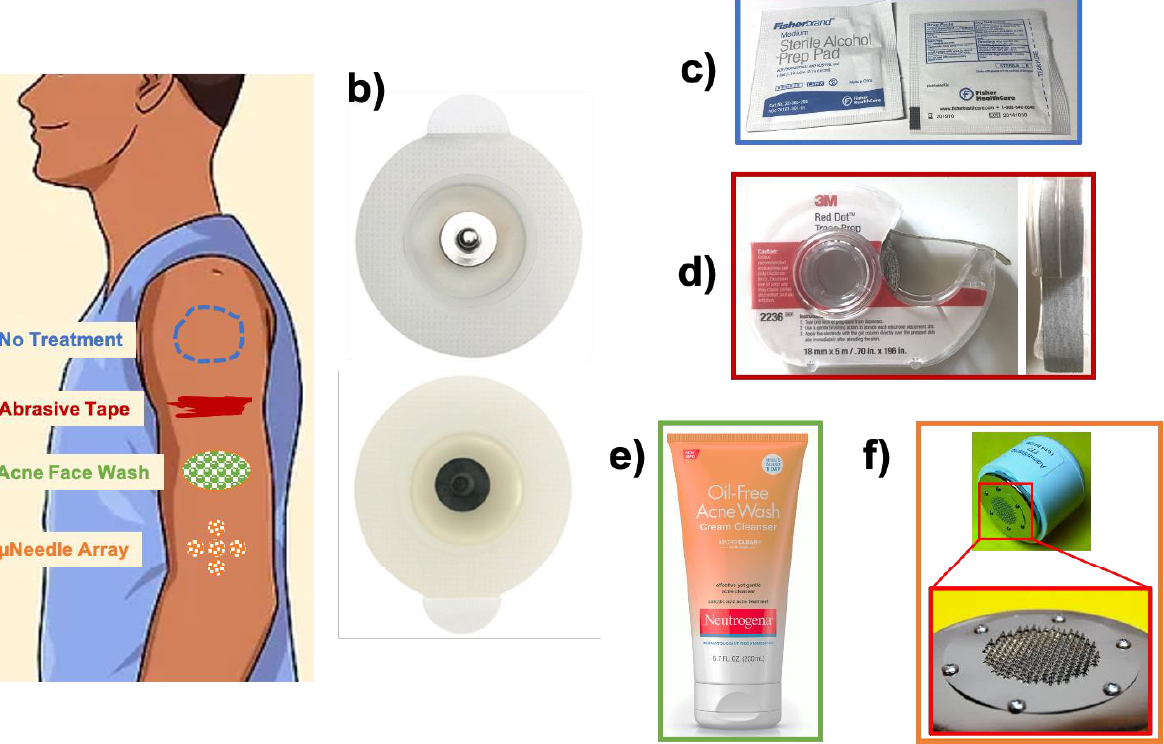
Figure 1. Electrodes and skin treatments used in the present study. ( a ) A cartoon schematic showing application of the four skin treatments to the upper arm. ( b ) Electrodes used in the study: Cleartrace TM 1700-O30 ECG pre-gelled Ag/AgCl disk electrodes (geometric surface area = 5.1 cm 2 , ConMed Co). ( c – f ) Skin treatment agents: ( c ) ‘No Treatment’ control (alcohol prep pad for pre-cleaning the skin); ( d ) 3M’s TracePrep TM abrasive tape; ( e ) Neutrogena ® Acne Face Wash (with 2% salicylic acid); ( f ) AdminPatch ® 0900 microneedle array